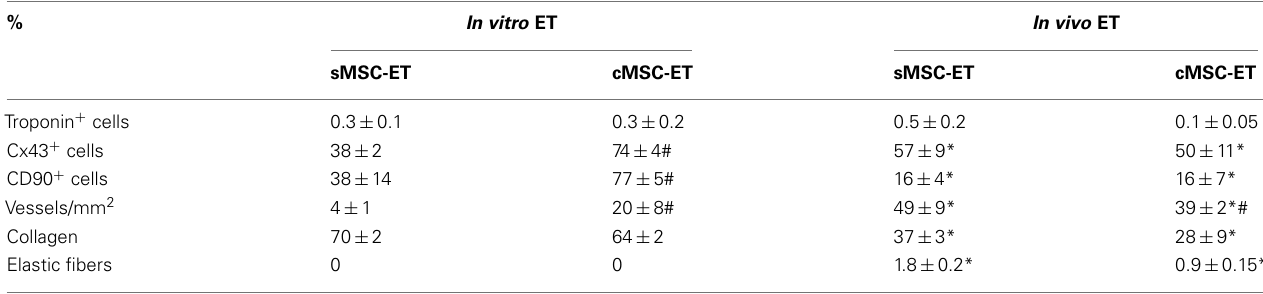
Table 2 | Characteristics of the engineered tissues (ET) made from the two groups of bone marrow derived stem cells used in this study. % In vitro ET In vivo ET